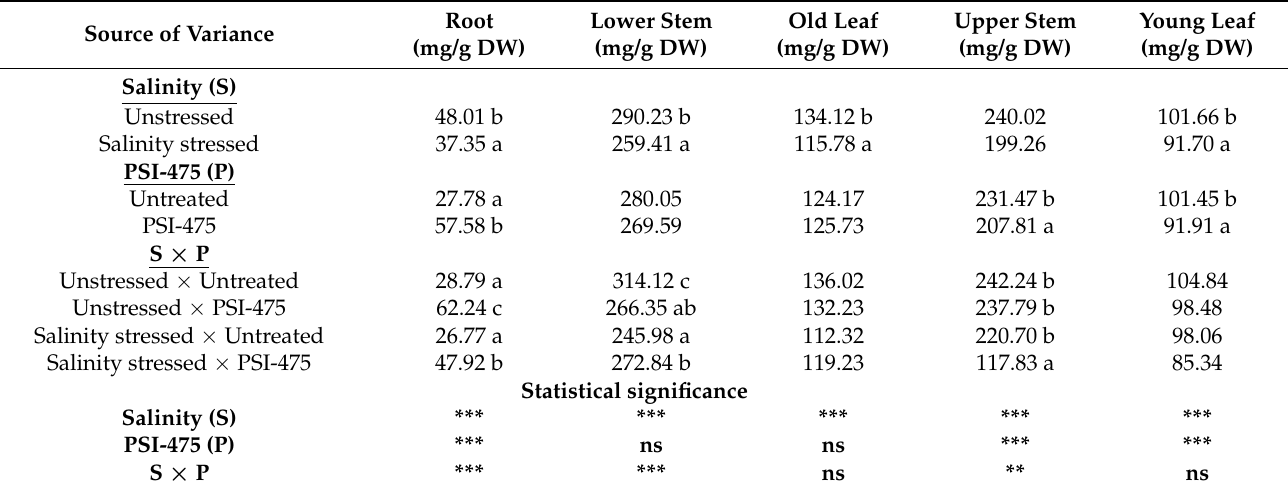
Table 3. Effect of salinity stress and PSI-475 on potassium (K + ) content in different tomato plant